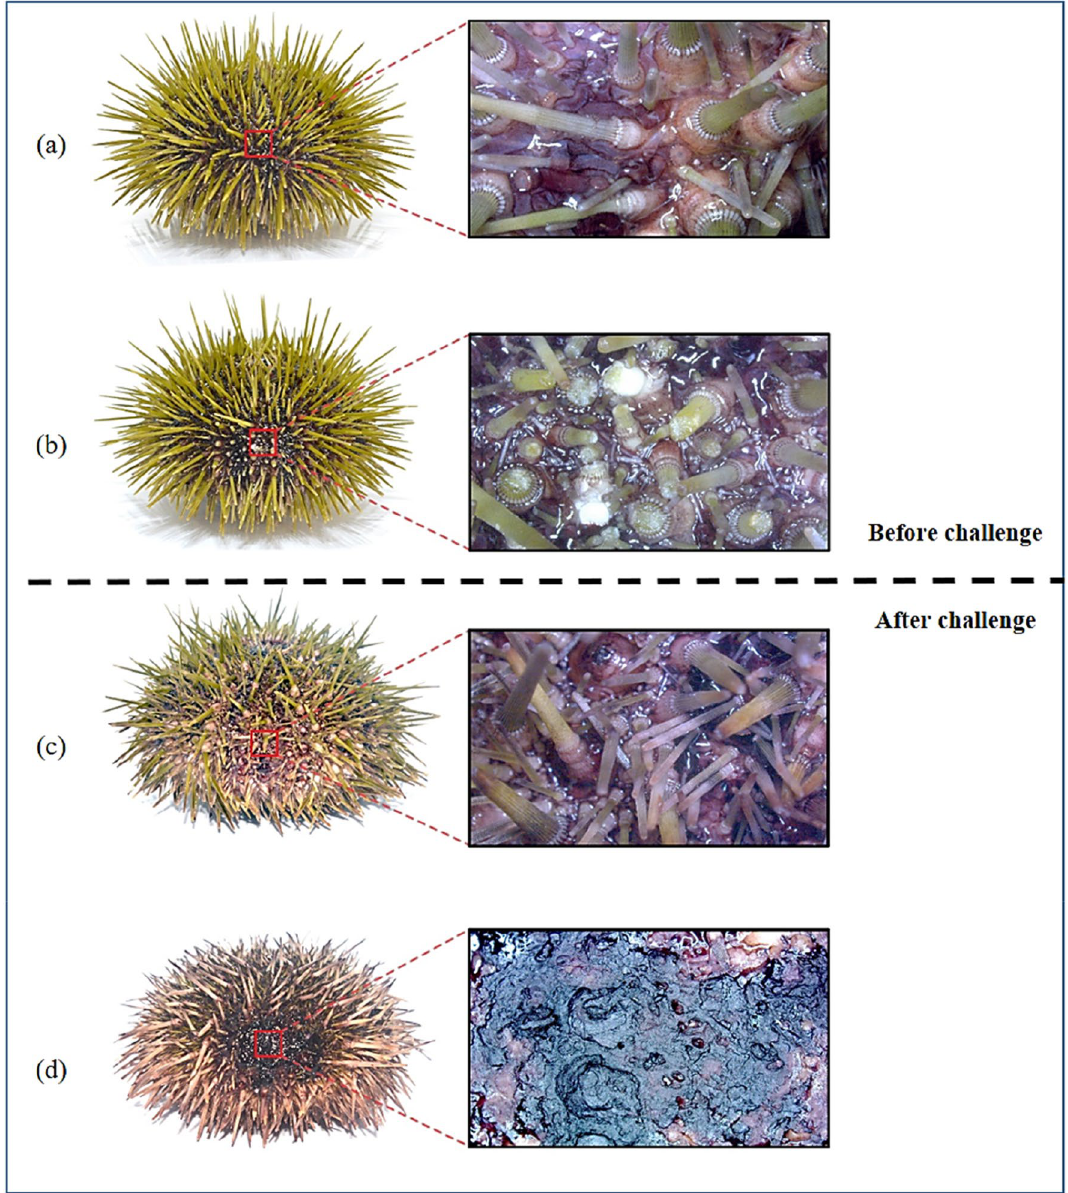
Figure 2. Green sea urchins ( S. droebachiensis ) before ( a , b ) and after ( c , d ) the in vivo bacterial challenge experiment with V. echinoideorum at ± 6–8 °C. ( a ) Healthy sea urchin before the challenge experiment and a closer macroscopic view of intact spines, pedicellariae, tube feet, and other external appendages. ( b ) Artificially wounded sea urchin (spines, pedicellariae, tube feet, and other external appendages were trimmed). ( c ) Recovery of spines, pedicellariae, tube feet, and other external appendages of artificially wounded sea urchin (control, not exposed to bacteria) at the end of the challenge experiment. ( d ) Artificially wounded sea urchin (exposed to bacteria) having necrotized tissues, devoid of spines, pedicellariae, tube feet, and other external spines with intact tissue, outer surface appendages and skeleton covering the whole ambulacral (ab) and inter- ambulacral (Iab) zone on the equator region of the sea urchin test area (Fig. 2a). Only the sea urchins that were mechanically abraded (Mab) around the ambulacral (ab) and interambulacral (Iab) zone (Fig. 2b), developed lesions on the exterior of sea urchin test upon exposure to V. echinoideorum . The unexposed Mab animals had no signs of lesions and as time went, spines were regenerated in the artificially wounded areas (Fig. 2c). The non-mechanically abraded (nMab) group exposed to bacteria, also had no characteristic lesions, but rather had crippled tube feet and reddish spines, demonstrating their progression of illness. Besides, the lesions developed in the infected sea urchins resembles the characteristic features of the naturally developed lesions in diseased sea urchins. The infected animals had an extended lesioned area covered with a dark reddish to black mucoid layer surrounded by fragmented material of necrotized tissues and lacking spines, pedicellariae, and tube feet